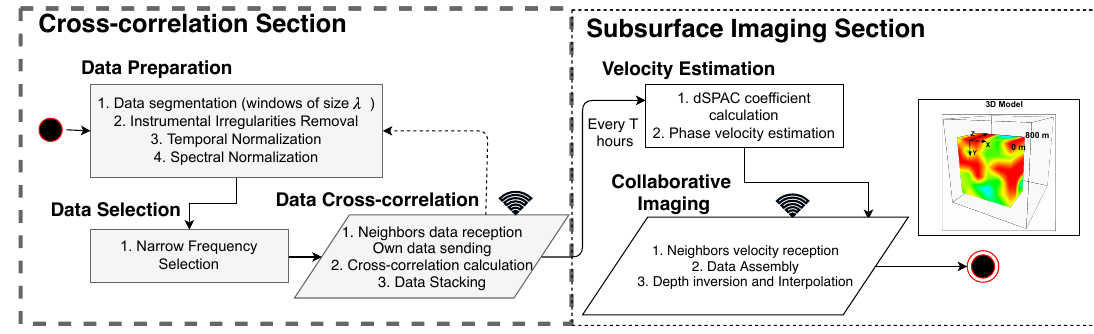
Figure 2. System methodology for distributed Spatial Autocorrelation (dSPAC) subsurface